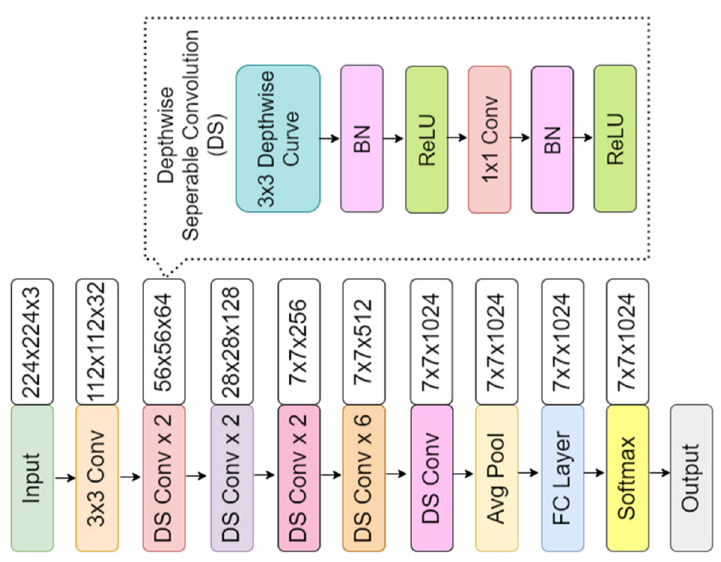
Figure 12. MobileNet architecture.